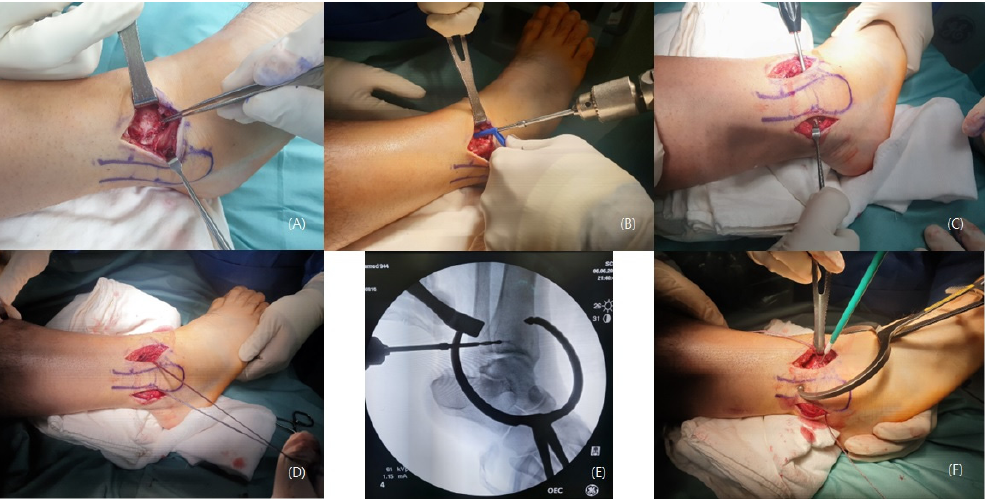
Figure 5. ( A ) Confirmation of anterior inferior tibiofibular ligament rupture. ( B ) Check of the distal tibial footprints and a 3.4 mm bone tunnel was created. ( C ) In the syndesmosis ligament in the distal fibula using a 2.7 mm drill. ( C ) A 2.7 mm drilling was performed on the footprints of the syndesmosis ligament in the distal fibula from front to back to create a bone tunnel. ( D ) Suture tape was passed through the bone tunnel and fixed with interference screws. ( E ) Under C-arm guidance, a bone tunnel was created in the posterior syndesmosis on the Volkmann tubercle side. ( F ) After reducing the syndesmosis joint, the free ends of the suture tape were fixed with 4.75 mm SwiveLock screws.